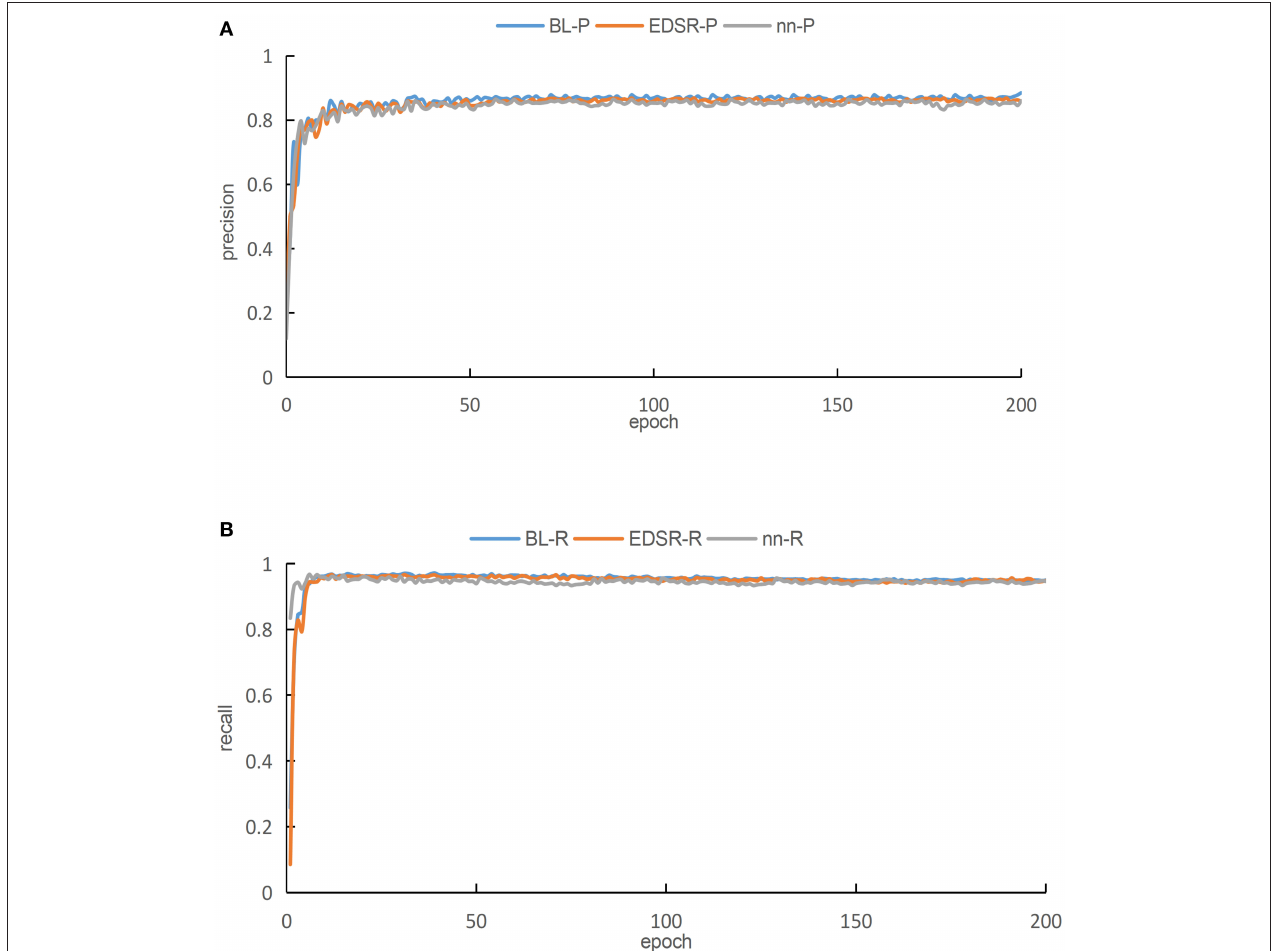
FIGURE 9 | The training results of YOLOv3-SPP network after image enhancement by using different super-resolution algorithms. (A) A comparison of accuracies for different super resolutions. (B) A comparison of recall for different super resolutions.